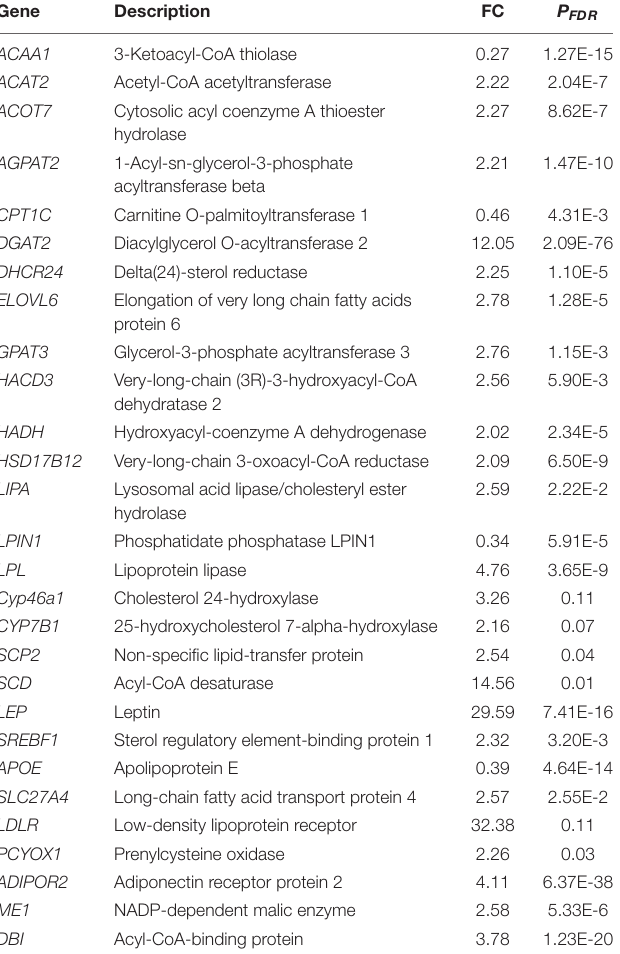
TABLE 3 | Important differentially expressed genes (DEGs) involved in fat metabolism in FY and MY subcutaneous